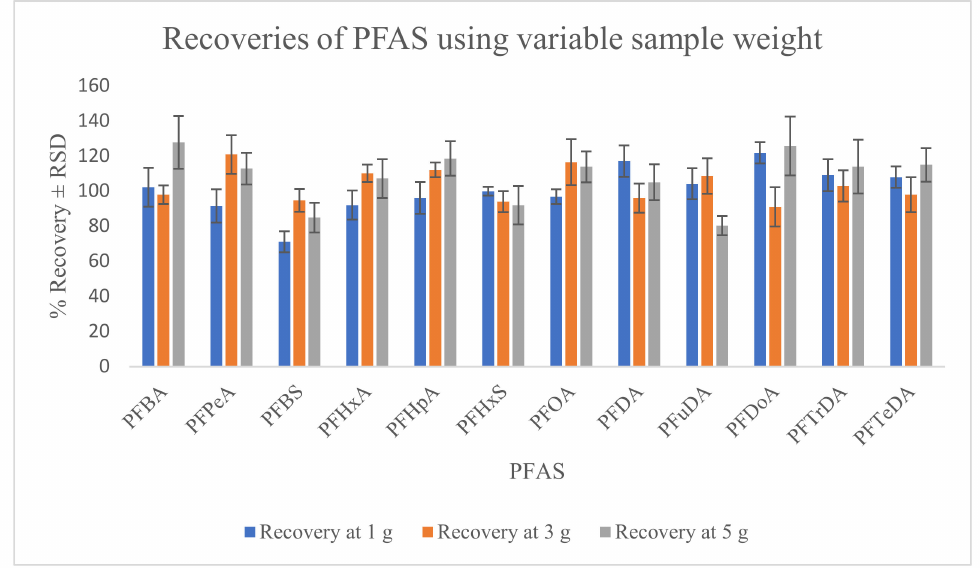
Figure 2. Recovery of PFAS using varying sample